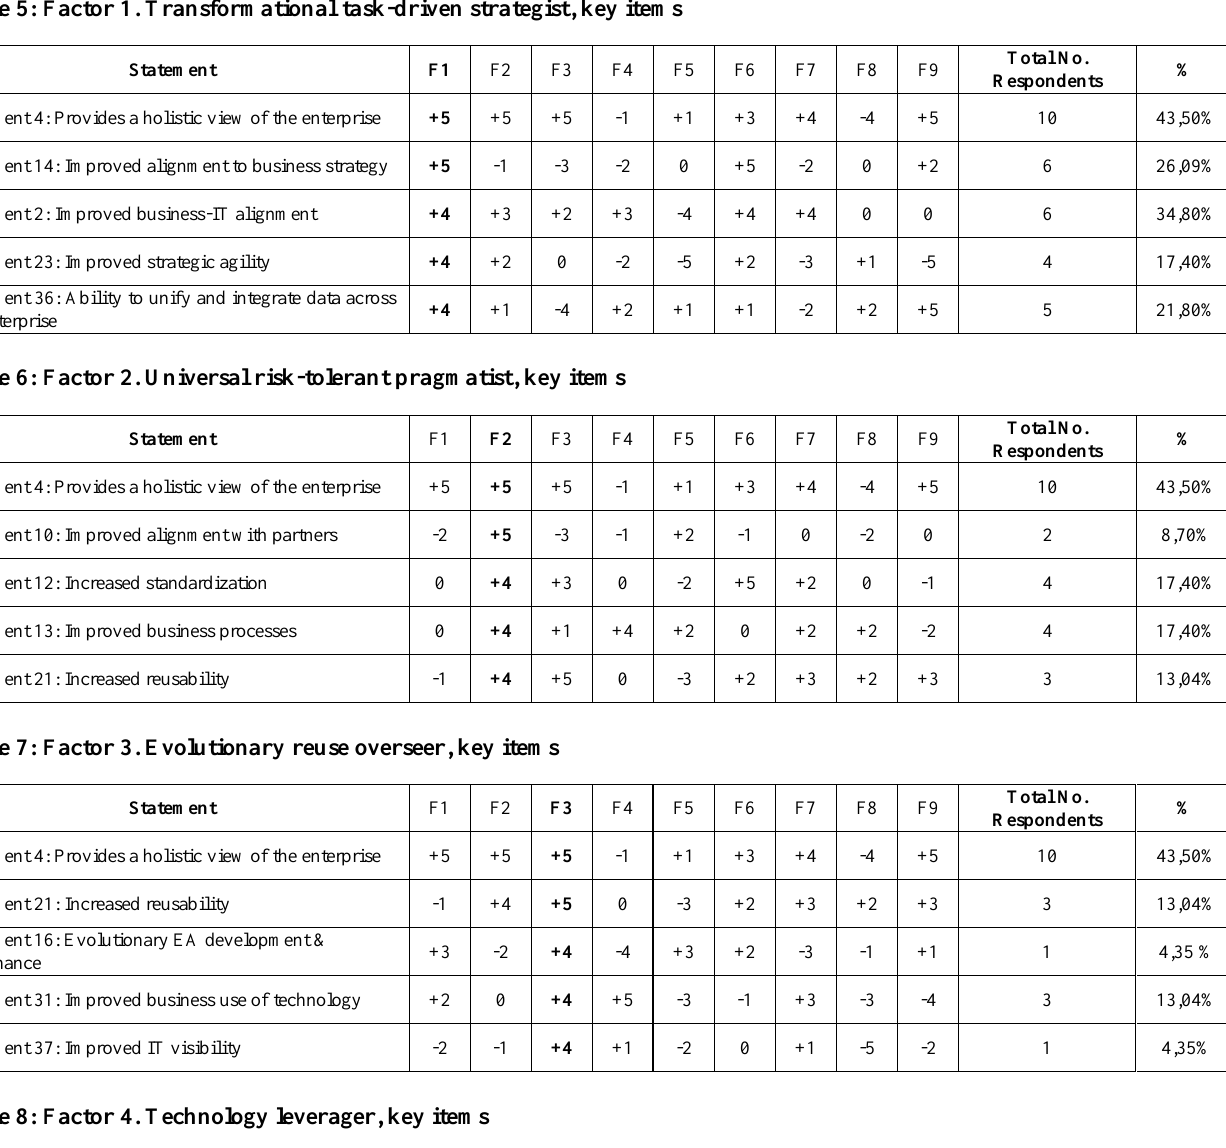
Table 5: Factor 1. Transformational task-driven strategist, key items